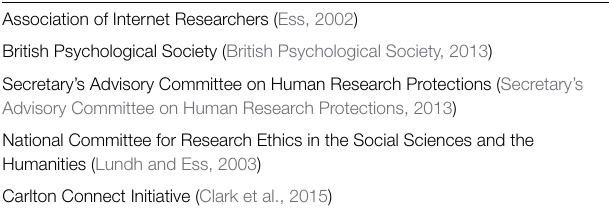
TABLE 2 | Universities with published guidelines for internet-based research and social media in pediatric clinical